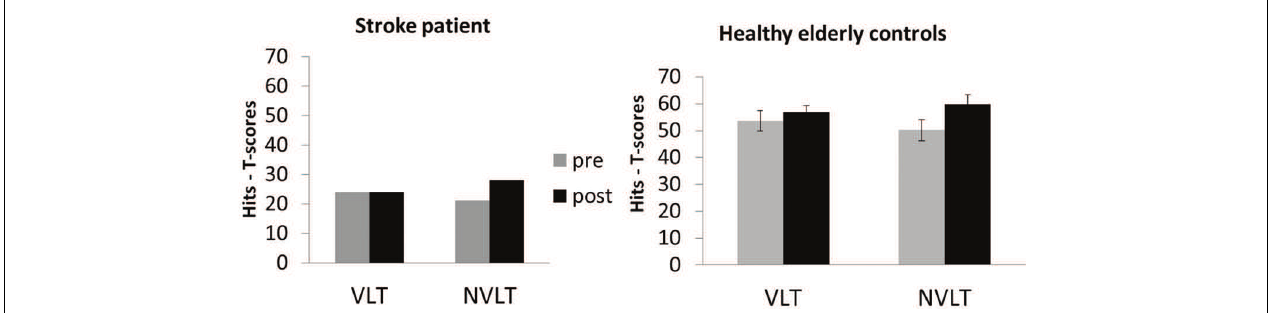
FIGURE 3 | Means and standard errors of the performance in the verbal learning task (VLT) and the non-verbal learning task (NVLT) for UG20 and the control group before and after NF training.